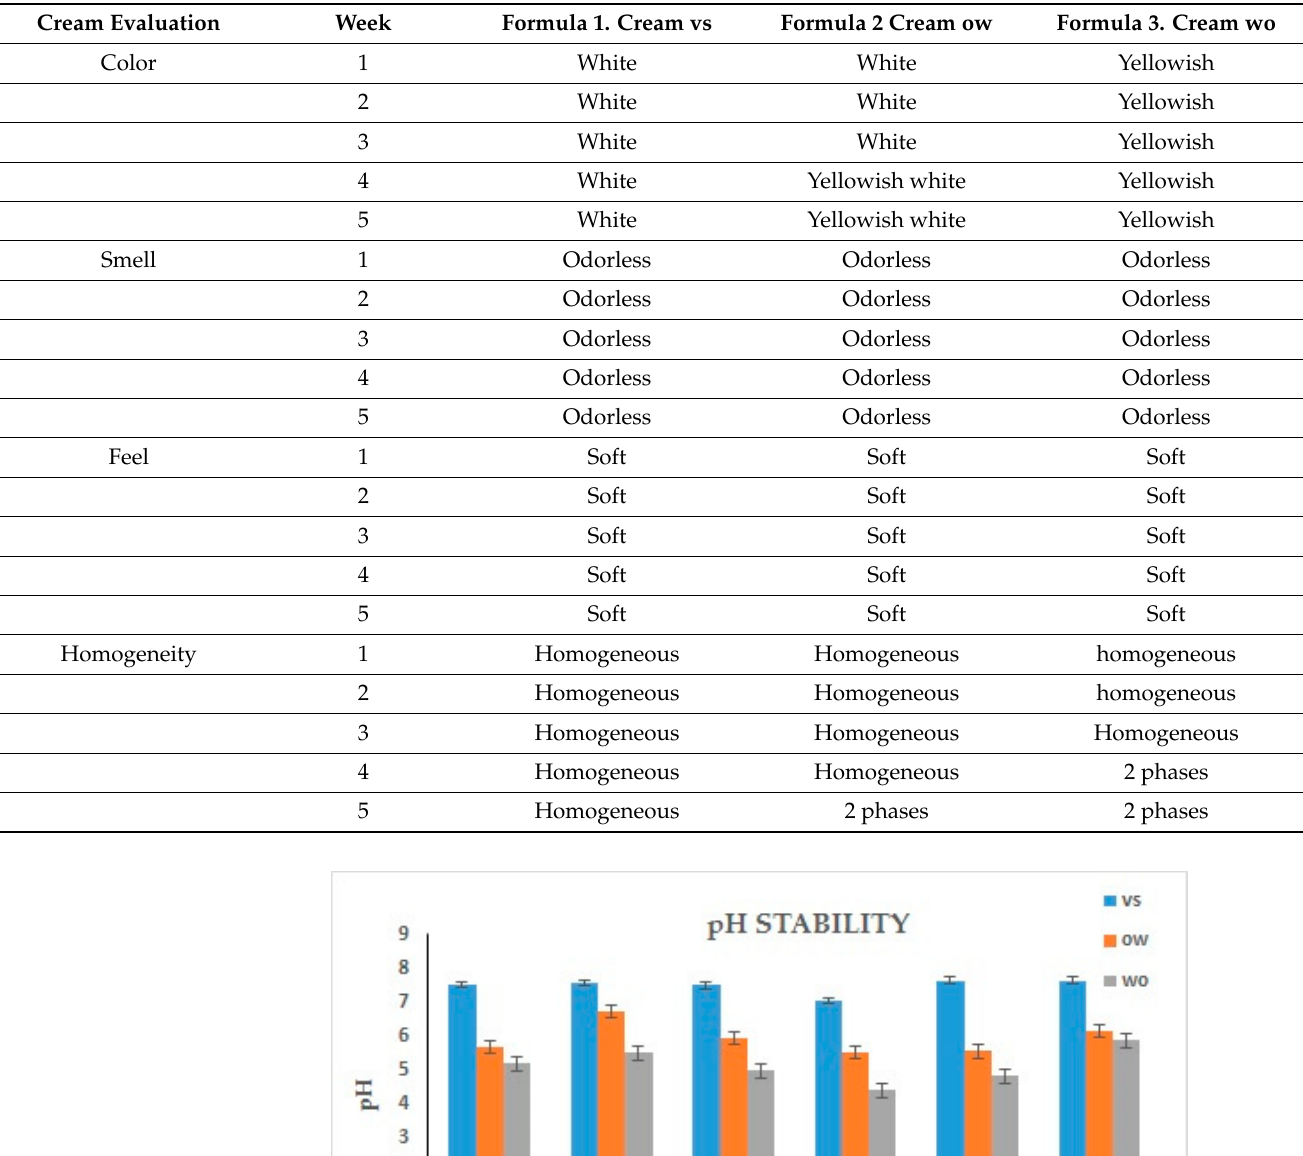
Table 3. Organoleptic stability of cream formulation.